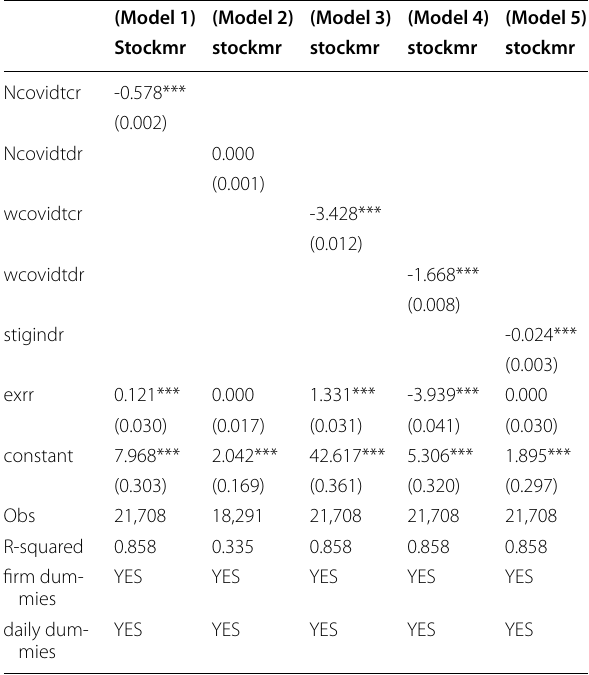
Table 5 Pooled OLS regression